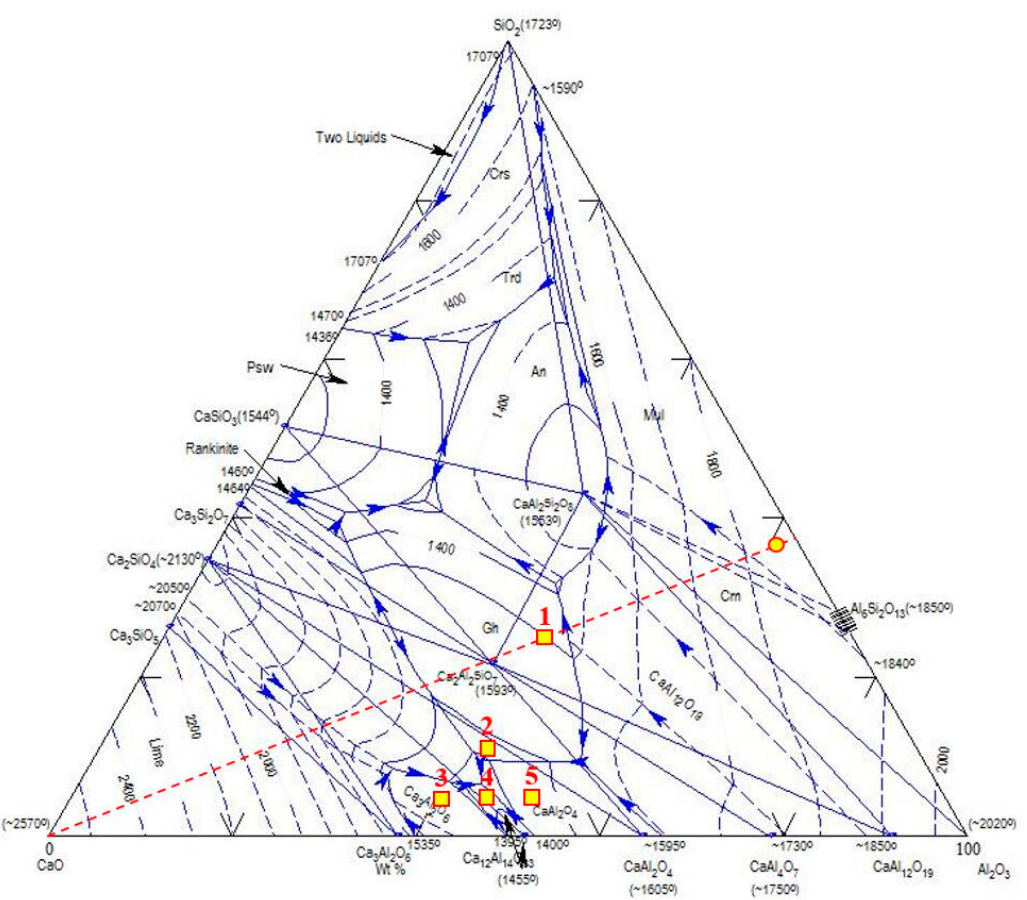
Figure 2. Composition design of smelting separation slag based on the phase diagram of CaO-SiO 2 -Al 2 O 3 . Table 3. Target of composition adjustment for smelting separation slag